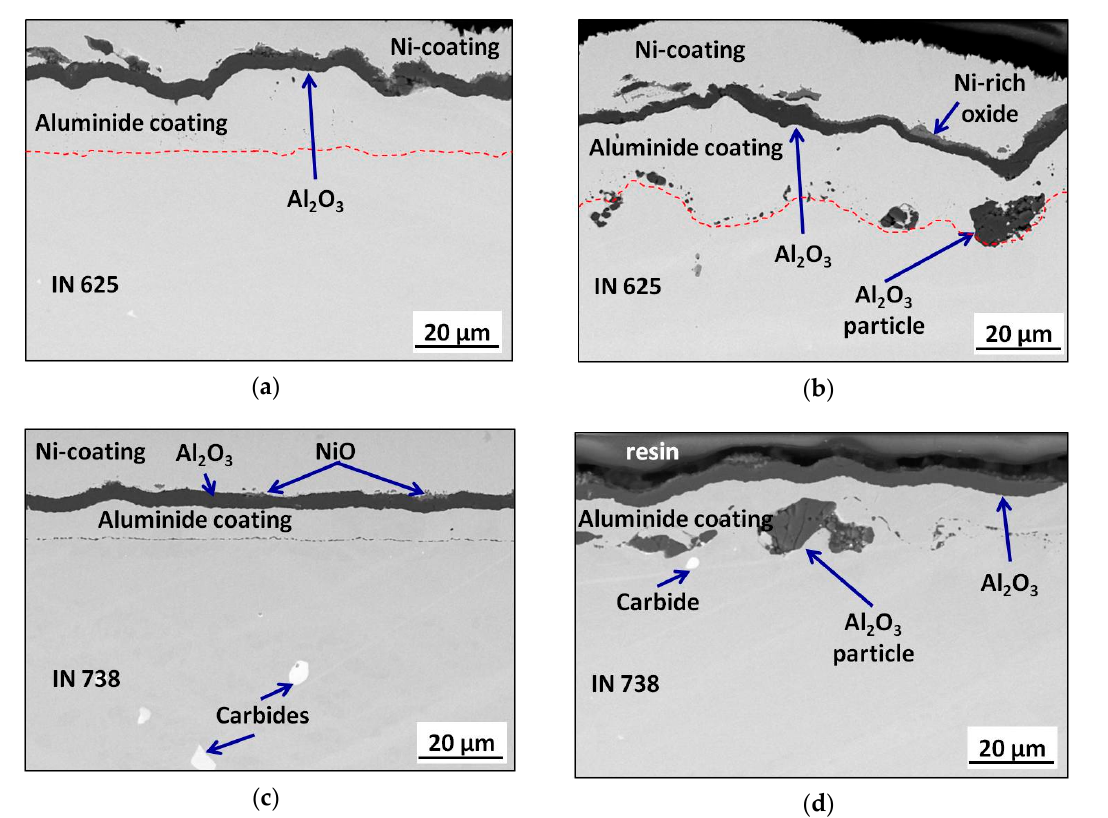
Figure 13. SEM/BSE images showing cross-sections of aluminide coatings formed on: ( a ) Ground IN 625, ( b ) grit-blasted IN 625, ( c ) ground IN 738, and ( d ) grit-blasted IN 738 after a thermal shocking test after 200 cycles.